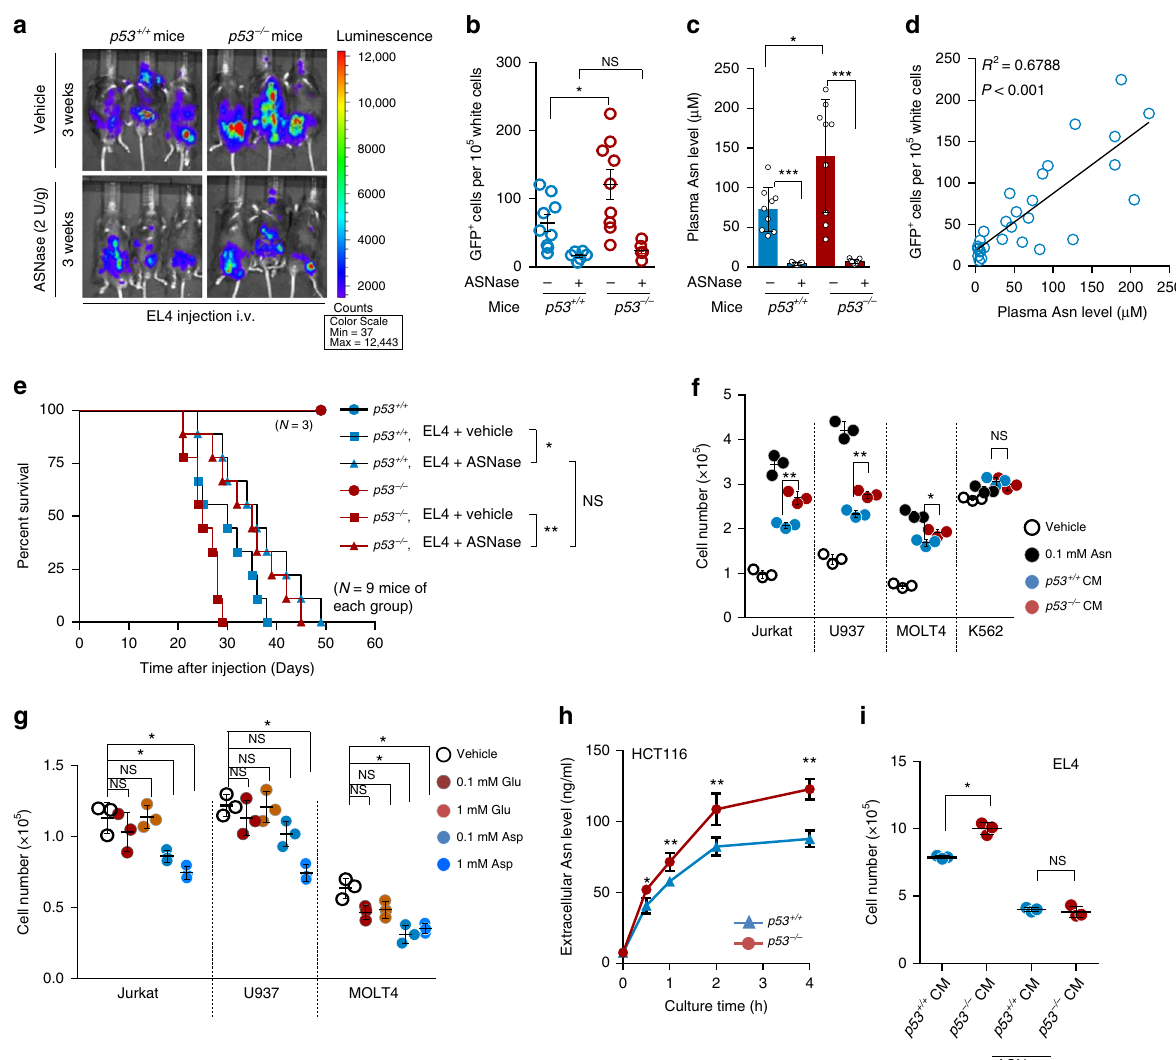
Fig. 1 p53 de fi ciency increases asparagine secretion to promote lymphoma proliferation. a p53 + / + and p53 − / − C57BL/6J mice injected i.v. with 5 × 10 5 EL4-Luc-GFP cells were treated i.p. with vehicle or ASNase (2 U/g) every 3 days for 3 weeks. Whole-mouse bioluminescence analysis and representative images are shown. The colour scale represents the intensity of emitted luminescence. Each group included 9 mice. i.v., intravenously; i.p., intraperitoneally. b Flow cytometry analysis of the frequencies of EL4-Luc-GFP cells (GFP + ) in peripheral blood in recipient mice as treated in a . Peripheral blood from mice without injection/treatment was used as a control. c p53 + / + and p53 − / − C57BL/6J mice were treated as in a , plasma Asn levels were determined by LC- MS. d Linear regression analysis of the concentrations of mouse plasma Asn and the number of EL4-Luc-GFP (GFP + ) cells in peripheral blood. n = 36 mice. e Kaplan – Meier survival curves of p53 + / + and p53 − / − C57BL/6J mice treated as in a . Mice without EL4 injection/treatment were used as controls ( n = 3). The signi fi cant differences among groups were determined by the log-rank (Mantel-Cox) test. f Proliferation of indicated cell lines cultured for 48 h in DMEM containing no or 0.1 mM Asn or cultured in p53 + / + or p53 − / − HCT116 cell conditioned-medium (CM) as indicated. g Proliferation of cells cultured in DMEM containing 0, 0.1 or 1 mM glutamate (Glu) or aspartate (Asp) for 48 h. h Asparagine levels in culture medium from p53 + / + or p53 − / − HCT116 cells at the indicated culture time points were measured. i The cultured medium from p53 + / + or p53 − / − HCT116 cells cultured for 24 h was used for culturing EL4 cells with 0 or 2 IU/ml ASNase for another 48 h. Cell proliferation was measured. Data are mean ± s.d., unpaired two-tailed Student ’ s t -test, * p < 0.05, ** p < 0.01, *** p < 0.001, NS not signi fi cant. Source data are provided as a Source Data fi